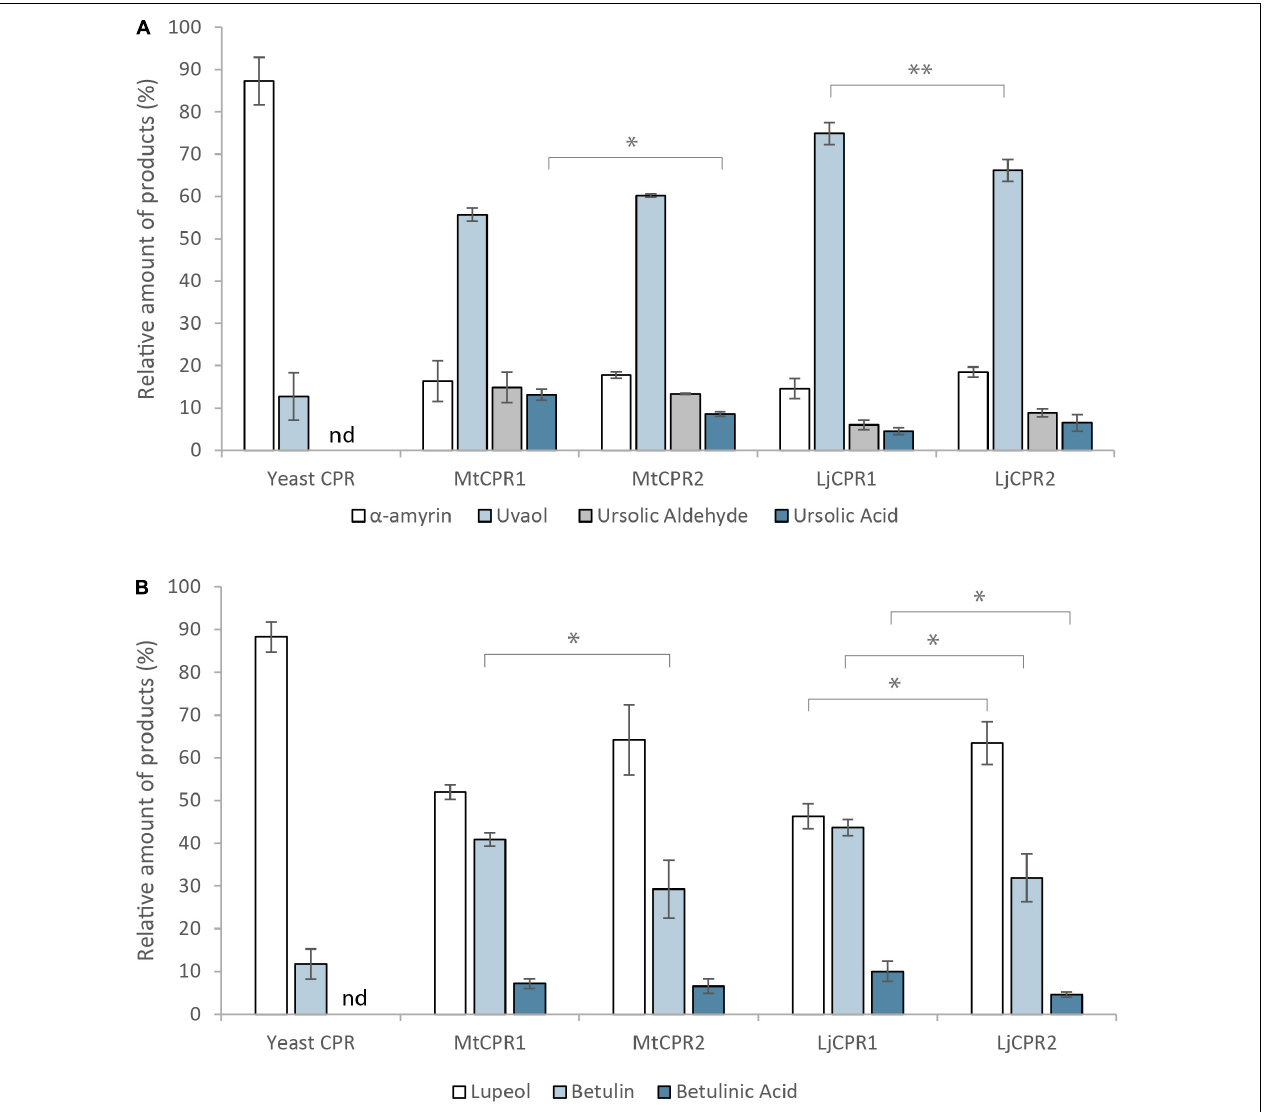
FIGURE 7 | The relative amount of triterpenoid produced by co-expressing MtCYP716A12 with different CPRs from M. truncatula , L. japonicus , and G. uralensis in (A) α -amyrin-producing and (B) lupeol-producing yeast (INV Sc1 strain). Triterpenoids content were measured relative to erythrodiol as internal standard. Data have been presented as mean ± SE ( n = 3). nd, signal below detection limit. Single-factor ANOVA was used for statistical comparisons. Values were considered statistically significant at * P < 0.05 and ** P <